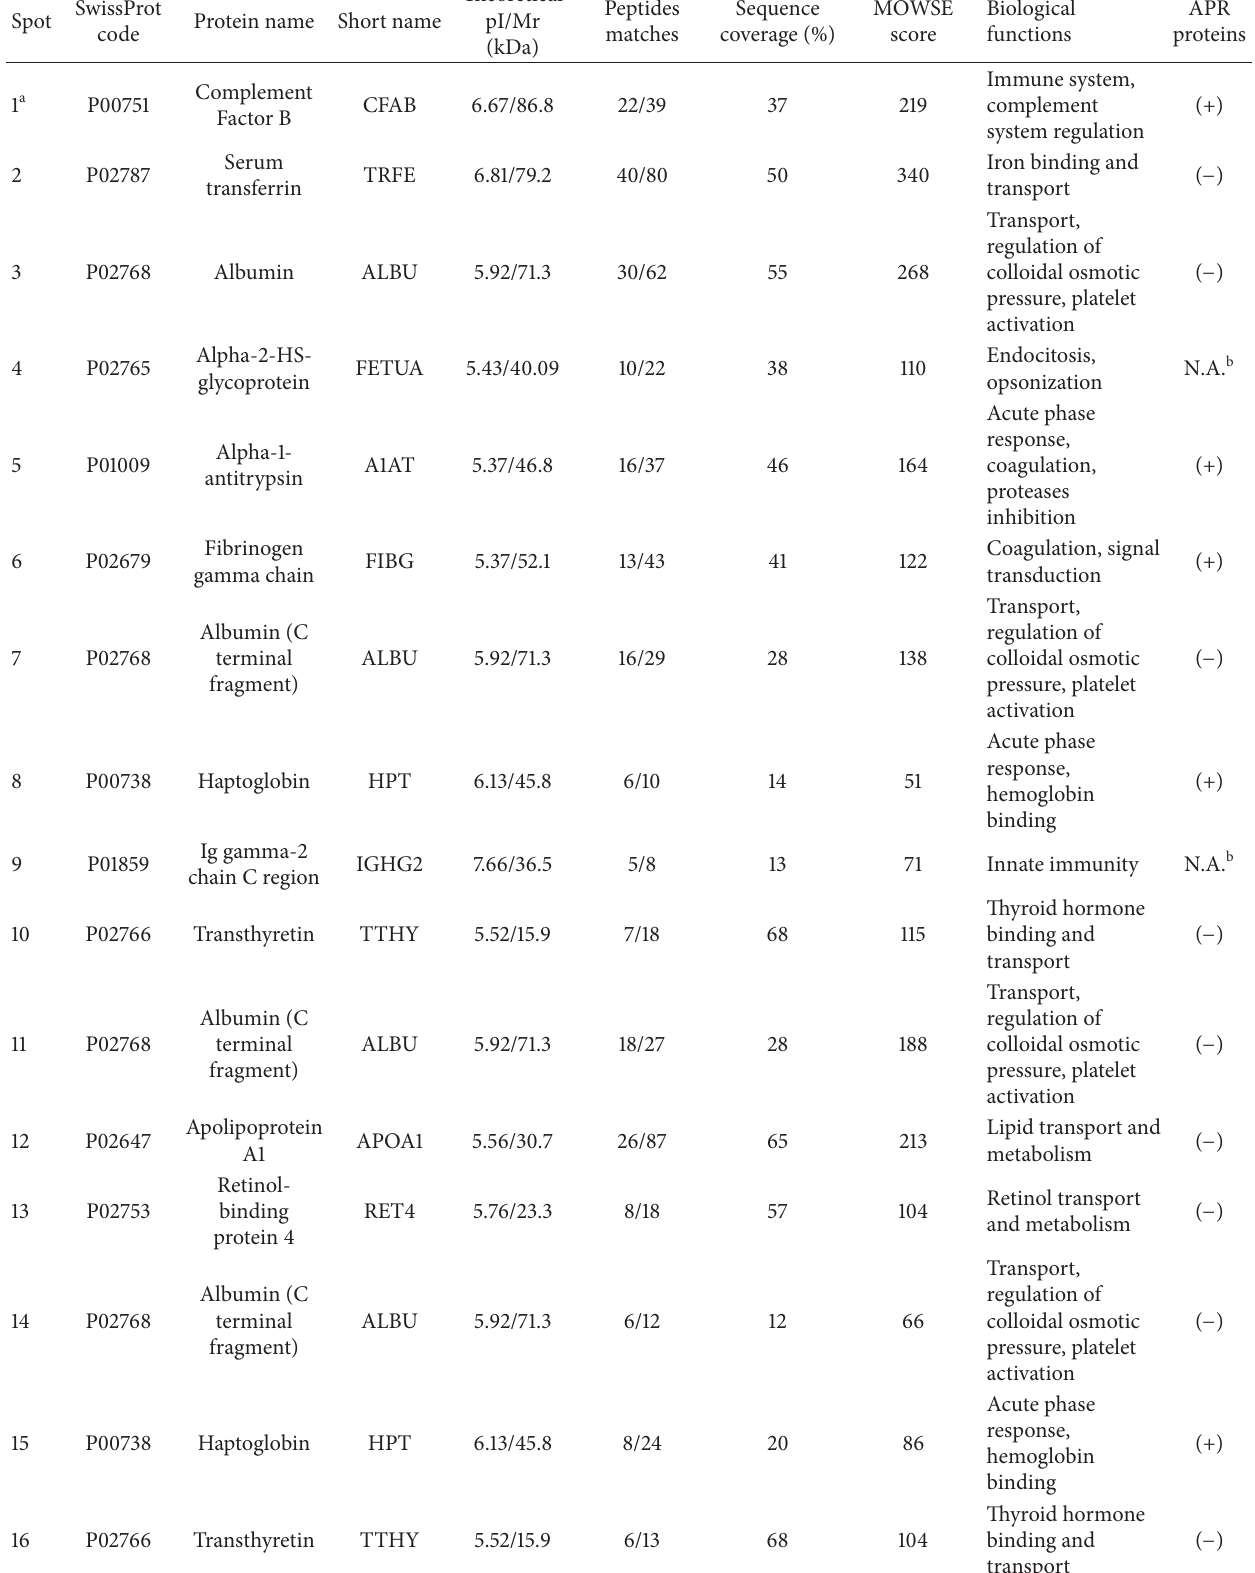
Table 1: Summary of the proteins identified as differently expressed using the proteomics approach. SwissProt Spot